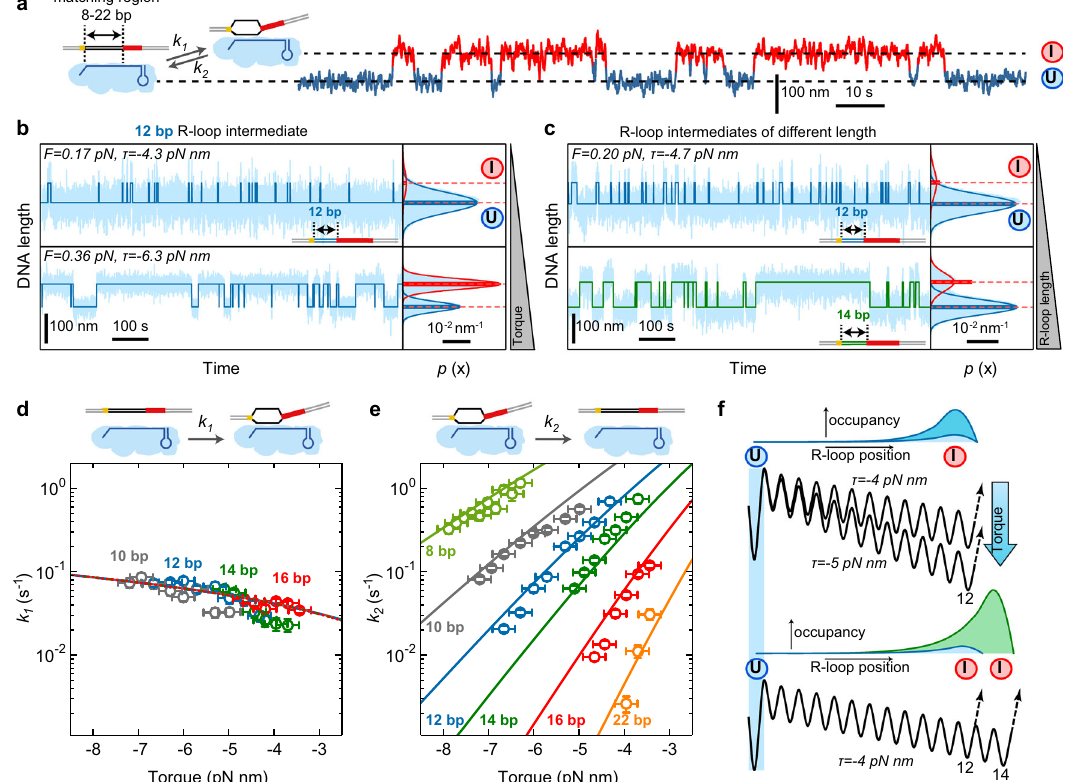
Fig. 2 | Formation and collapse rates of R-loop intermediates of different lengths. a Sketch of the DNA construct containing a limited number of matching PAM-proximal bases such that only R-loop intermediates form (left). Example tra- jectory of the transitions between unbound state ( U ) and intermediate R-loop ( I ) for a target with 12 matching bases. b Formation and collapse of R-loop inter- mediatesrecordedatdifferenttorques τ foratargetwith12matchingbases.Shown are the recorded DNA length smoothed to 7.5Hz (light blue) and a two-state approximation of the trajectory (dark blue). Solid lines in the histograms on the right represent Gaussian fi ts to the 2 different states, whilehorizontal dashedlines indicate the average DNA length of each state. Bars represent theoretically